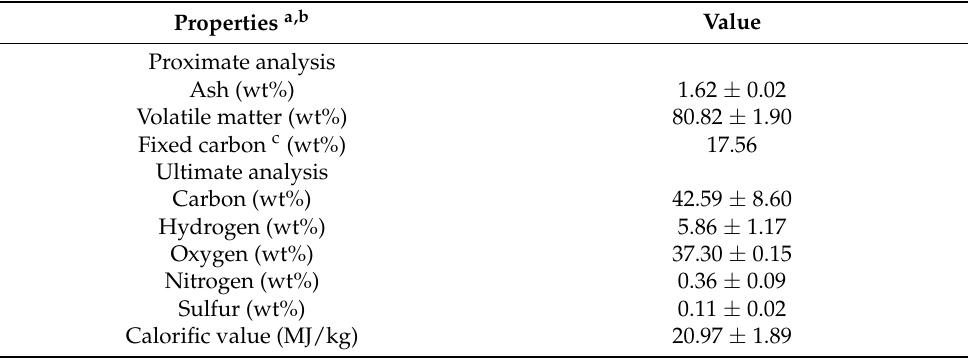
Table 1. Thermochemical properties of the Sapindus pericarp (SP) extraction residue.